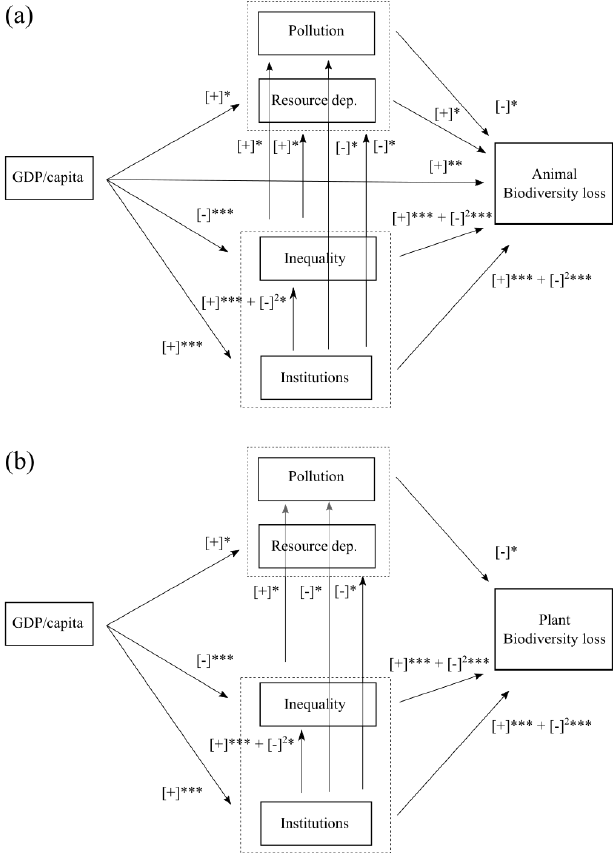
Fig. 5 . Effect pathway analysis revealing the nature of direct and indirect routes by which economic growth affects animal and plant biodiversity loss. A single sign denotes a linear relation, while a combination of two signs represents nonlinear quadratic behavior. See Tables 1 and 2 for coefficient